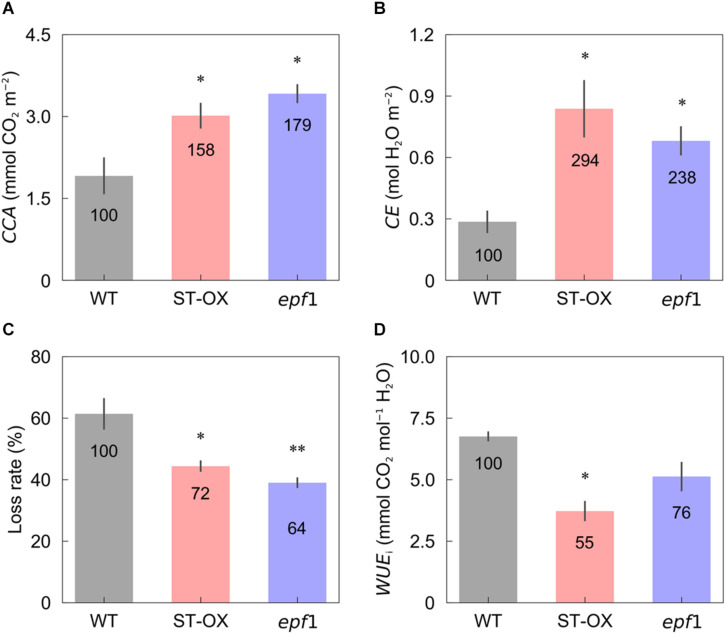
Cumulative carbon gain and water use after step increase in light. (A) Cumulative CO2 assimilation (CCA) and (B) transpiration (CE) were measured in the first 10 min under illumination after initial darkness in the three lines of Arabidopsis under the fluctuating light. (C) The loss rate of CO2 assimilation caused by the induction response was calculated based on Eq. 3. (D) Integrated water use efficiency (WUEi) was calculated as the ratio of CCA to CE. Vertical bars indicate the standard error (n = 3). * and ** indicate significant differences in each parameter between WT and each transgenic line at p < 0.05 and 0.01, respectively, according to Dunnett’s test. The value in each column represents the relative value of each line to WT.